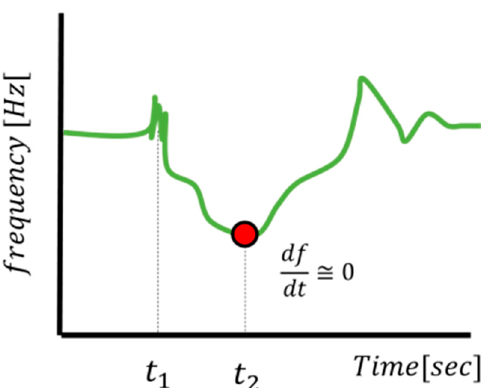
Figure 6. Contingency scenario in area 2.